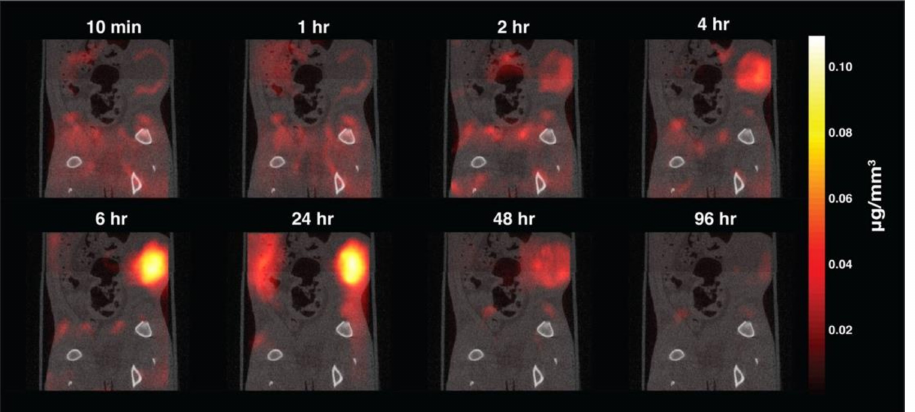
Figure 2. The imaging results of MPI volume coregistered to corresponding CT slices allow clear visualization of tracer dynamics in rats, including initial rim enhancement followed by accumulation and clearance. Image reproduced, with permission, from Reference [8]. Copyright 2017 American Chemical